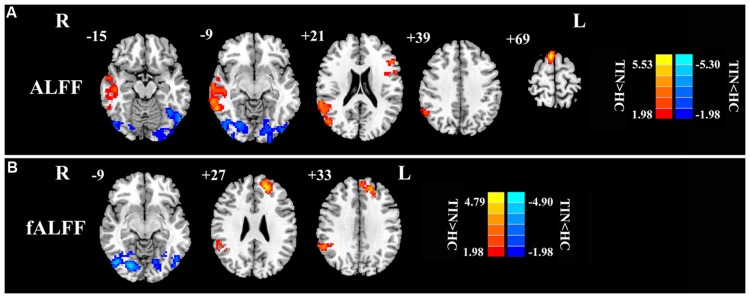
The main effect of group on: (A) ALFF and (B) fALFF. Red/hot colors represent higher ALFF (t-values 1.98 to 5.53; red to yellow, respectively) or fALFF (t-values 1.98 to 4.79; red to yellow, respectively) in the tinnitus group than in the control group while blue/cold colors represent lower ALFF (t-values –1.98 to –5.30; dark blue to light blue, respectively) or fALFF (t-values –1.98 to –4.90; dark blue to light blue, respectively) in the tinnitus group than controls. Results obtained by a two-way repeated-measure ANOVA. AlphaSim corrected p < 0.05 (individual voxel threshold p < 0.05 with a minimum cluster size of 3591 mm3). Tables 3 and 4 show regions where significant increases and decreases occurred.